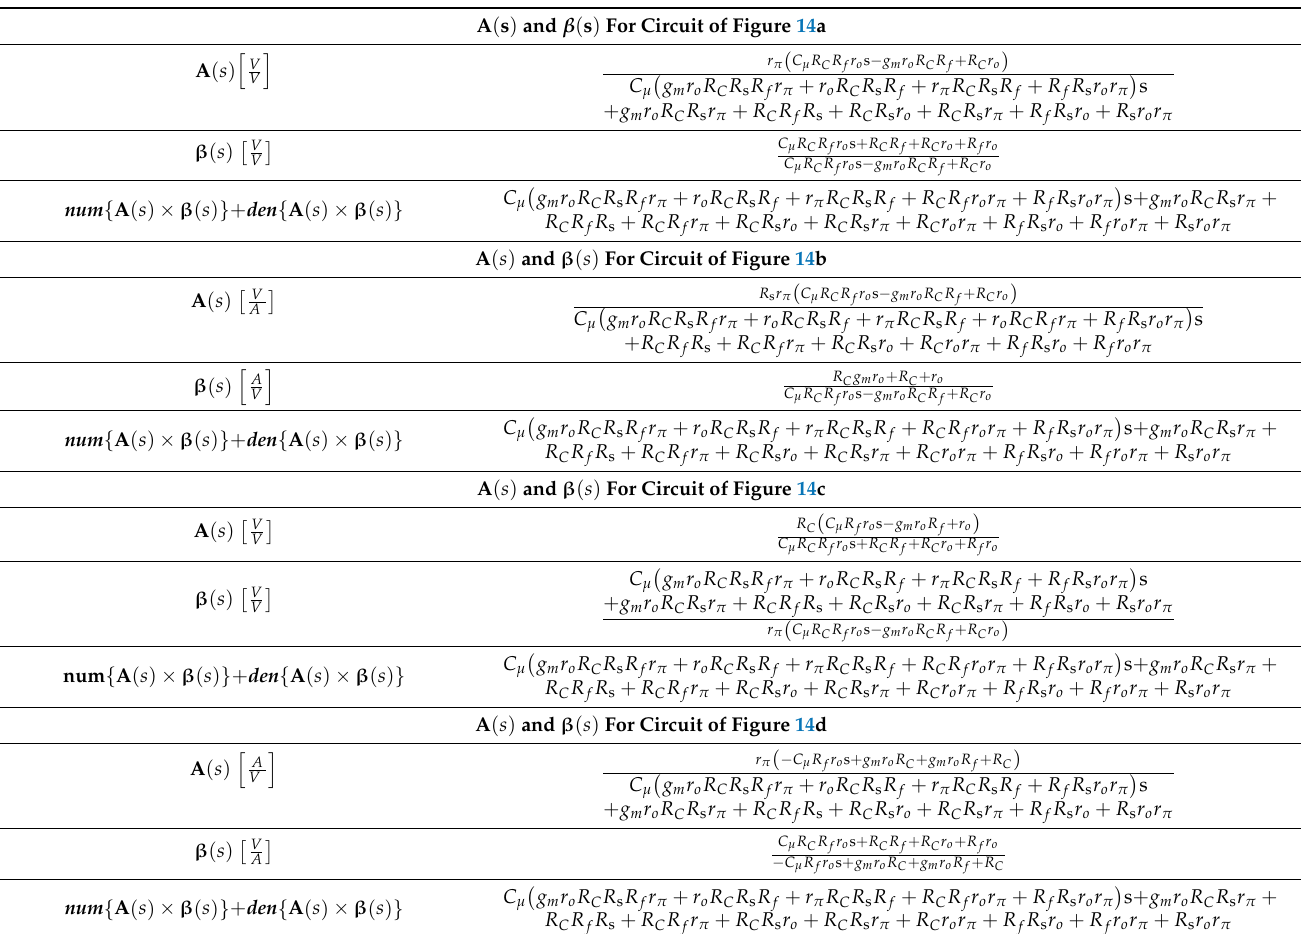
Table 2. Feedback parameters A ( s ) and β ( s ), and their combined sums for the circuits of Figure 14 (Green shaded row indicates